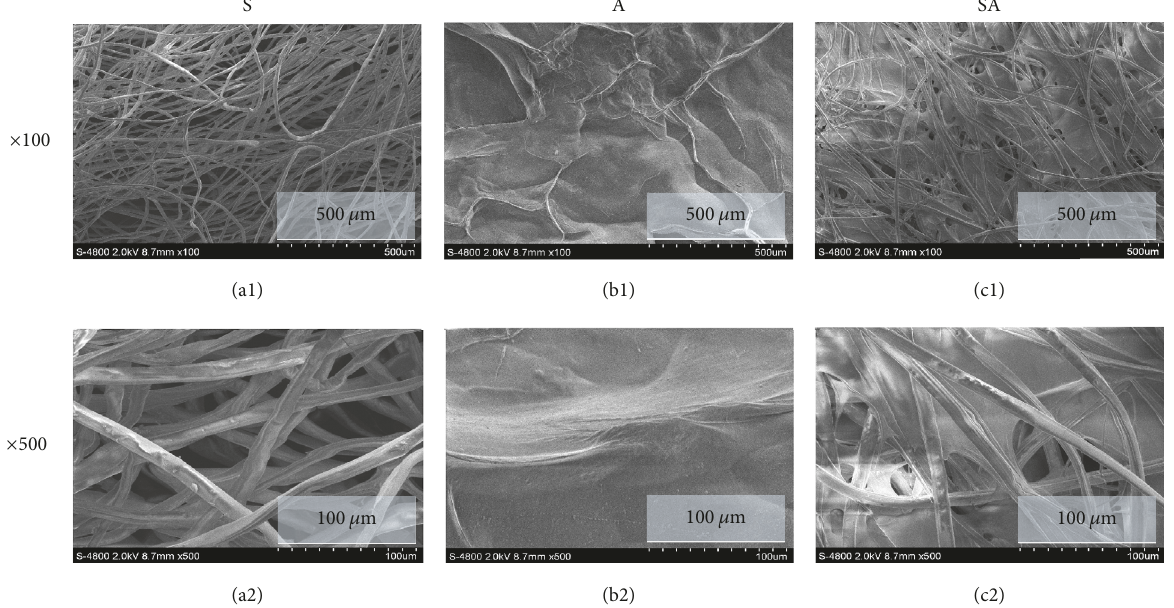
Figure 2: SEM images of 3 studied scaffolds at 2 magnifications ( × 100 and × 500): (a1, a2) S scaffold, (b1, b2) A scaffold, and (c1, c2) SA scaffold.